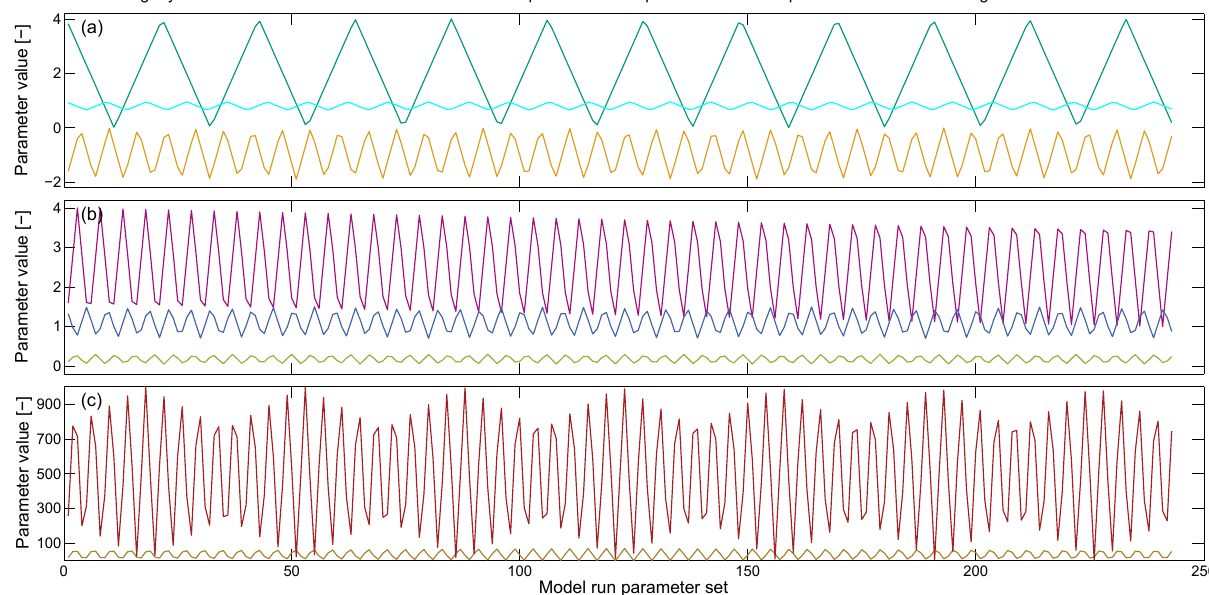
Figure 2. (a–c) Variations of the eight selected global mHM parameters for 243 model runs with independent frequencies according to the FAST sampling plotted as connected curves (see also Table